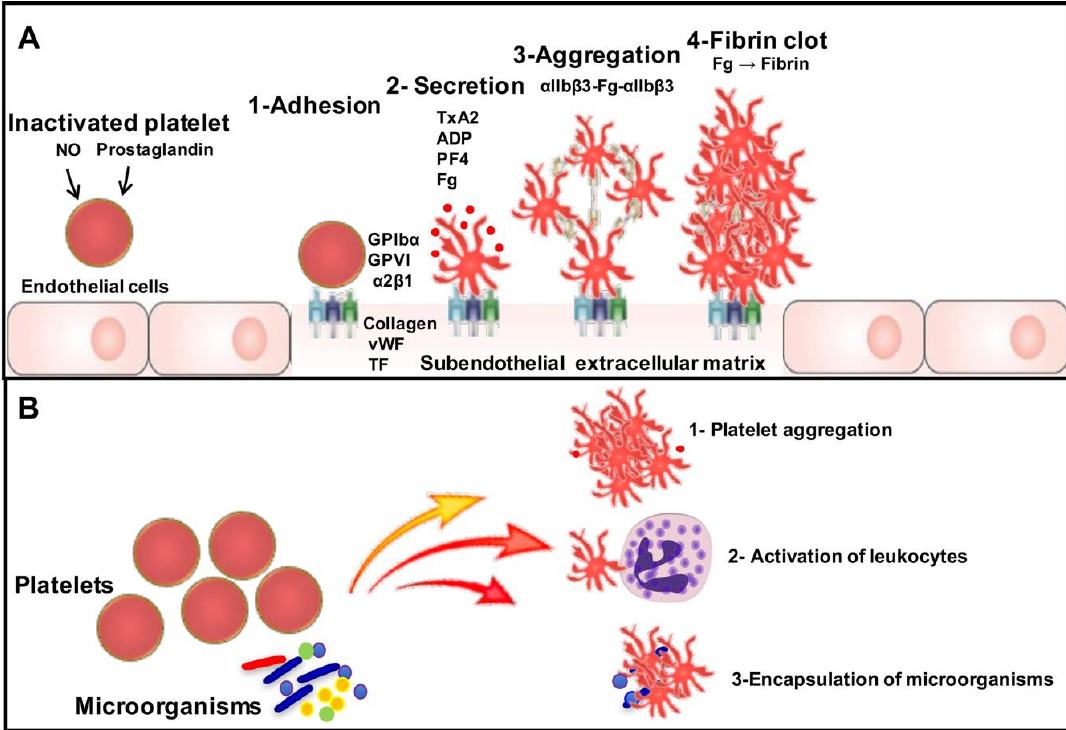
Figure 1. Schematic representation of platelet role in haemostasis, and during the course of infection. ( A ) Platelets circulate in an inactive state, maintained by prostacyclin (PGI2) and nitric oxide (NO) secreted by endothelial cells. During a lesion to the endothelium, collagen, vWF and tissue factor (TF) are exposed, activating platelets. These platelets adhere to the site of damage through a series of molecular interactions between platelet receptors (GPIbα, GPVI, α2β1) that bind directly to collagen and vWF, and once activated, the platelets secrete different molecules such as ADP, PF4, serotonin, fibrinogen (Fg) or TxA2, which attract circulating platelets and activate them. Inside-out signalling leads to the activation of talin and kindlin resulting in conformational changes to integrin αIIbβ3 that promote exposure of the Fg binding site and platelet aggregation via αIIbβ3-fibrinogen-αIIbβ3 bridges. Blood clotting is catalysed by thrombin, which promotes Fg binding to αIIbβ3 and converts Fg to fibrin. (B) During the course of infection with microorganisms, platelets can be activated by three mechanisms. The first mechanism is platelet aggregation, the second is leukocyte activation, in particular neutrophils, and the third is the encapsulation of microorganisms by platelets.